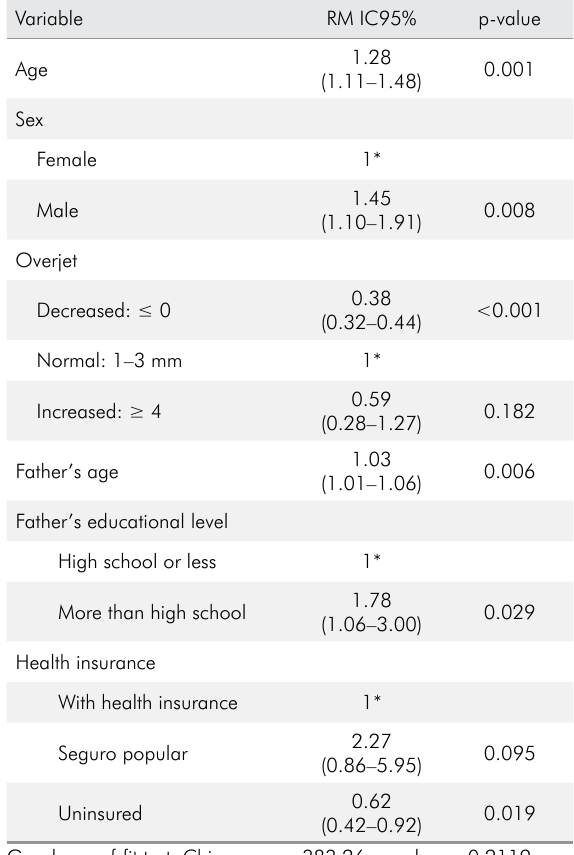
Table 4. Logistic regression analysis between dental trauma and the independent